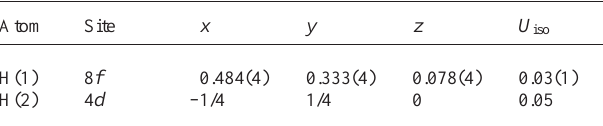
Table 2. Atomic coordinates and displacement parameters (in Å 2 )